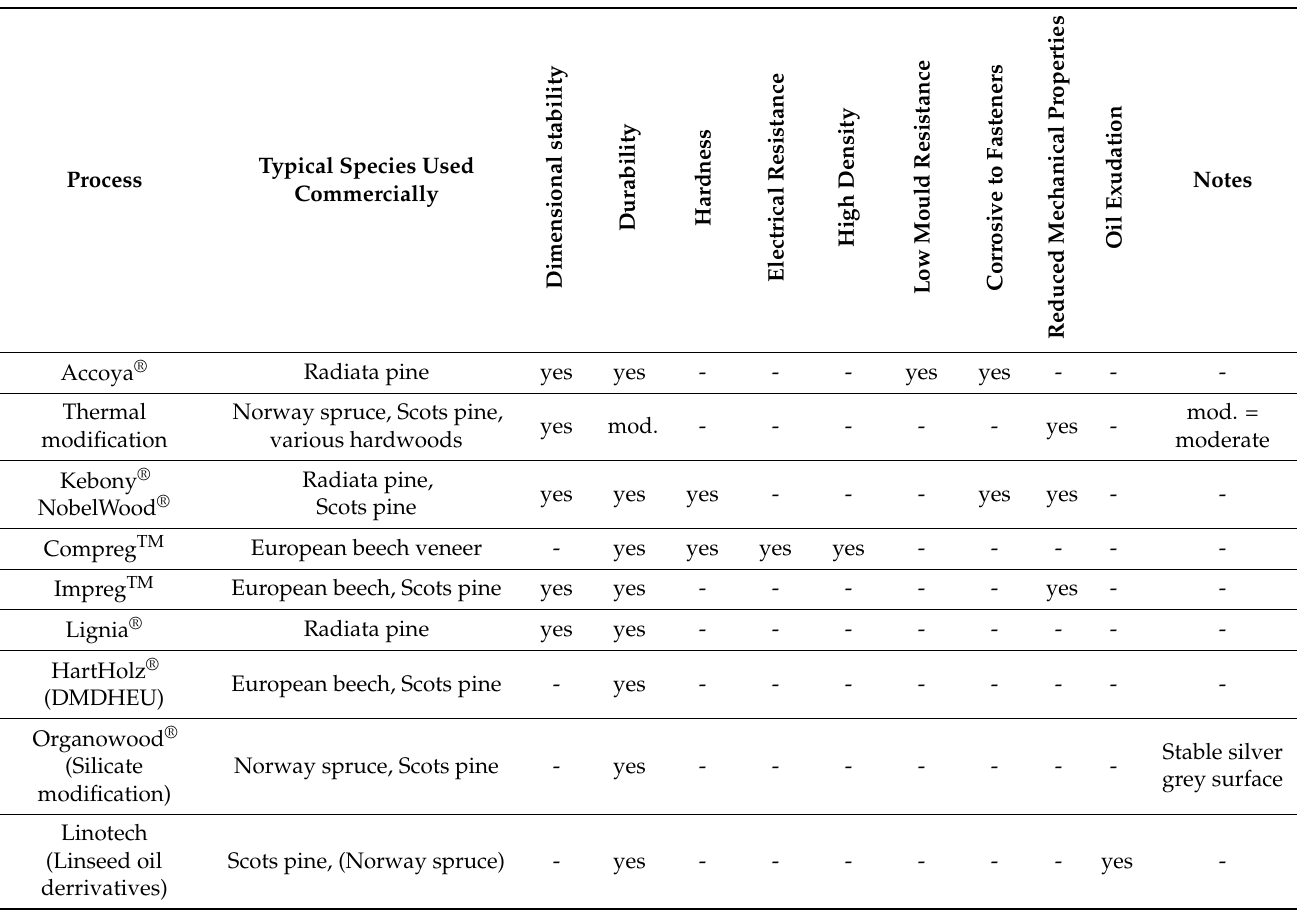
Table 2. Commonly achieved properties of modified wood from various systems (based on [6]).